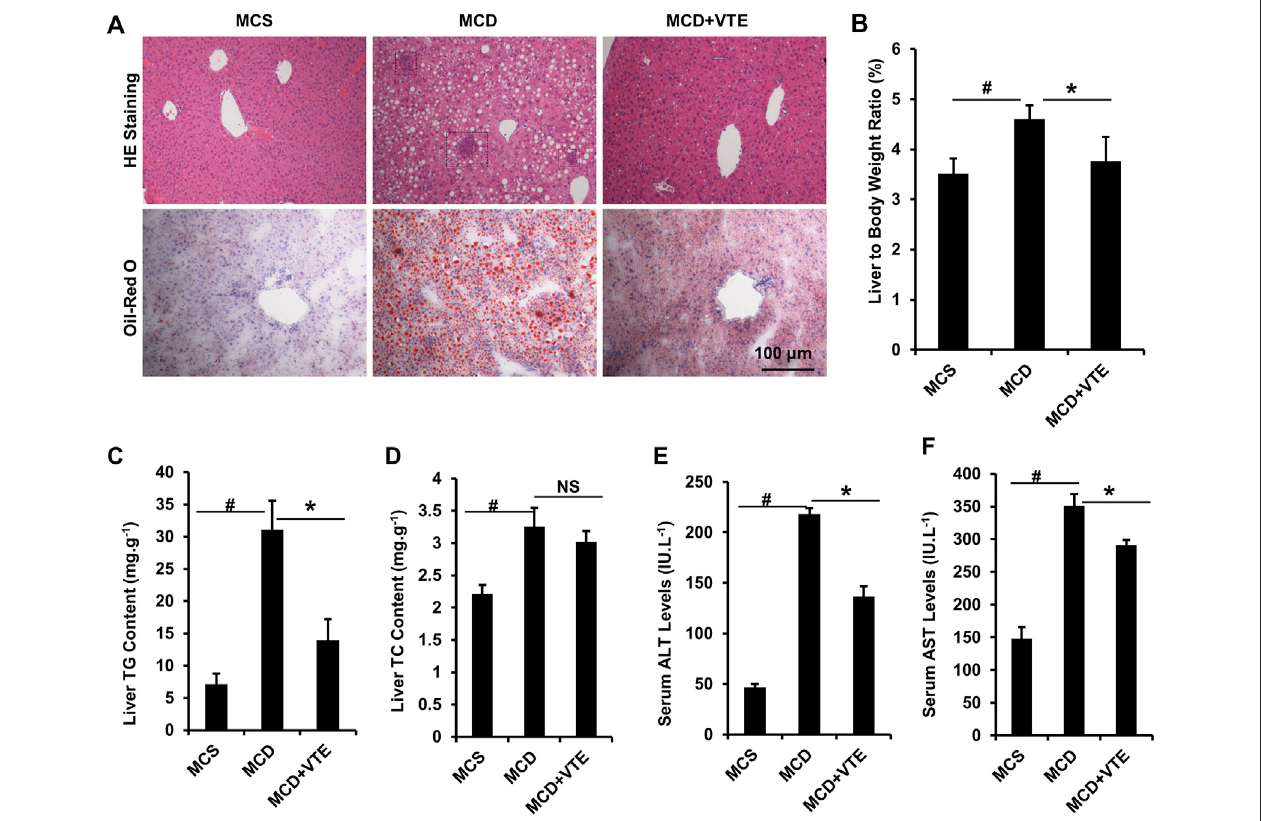
FIGURE3| VTEresiststoNASHinMCDD-fedmice.MaleC57BL/6Jmice(20 ± 2 g)werefedanMCDdietinthepresenceandabsenceofVTE(1 g100g − 1 diet)for 6 weeks (A) Haematoxylinandeosin(HandE)andOilRedOstainingofliversfromtheMCSdiet-,MCDdiet-andMCD+VTE-fedmice.Scalebars,100 μ m (B) Theratio of liver to bodyweight of the mice (C, D) The quantitative results of TG and TC content in livers (E) Serum ALT levels (F) Serum AST levels. The data are presented as mean ± SEM. n (cid:2) 5 − 6 for all groups. # p < 0.05, MCD compared with the MCS group. * p < 0.05, MCD compared with the MCD + VTE group. NS, no signi fi cance. Dotted rectangles denote hepatic in fl ammatory cell in fi